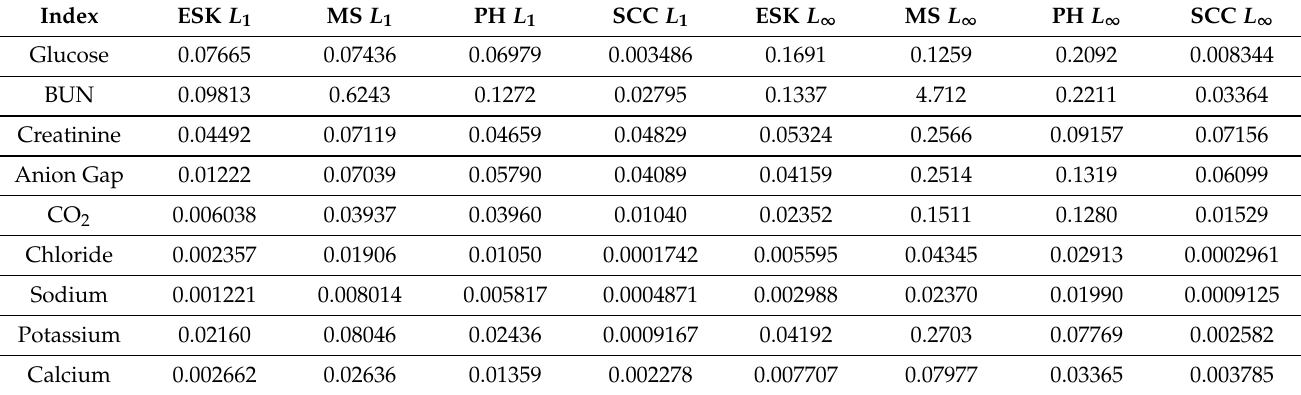
Table 8. Relative L 1 and L ∞ errors for all 9 indices of the patients at L =